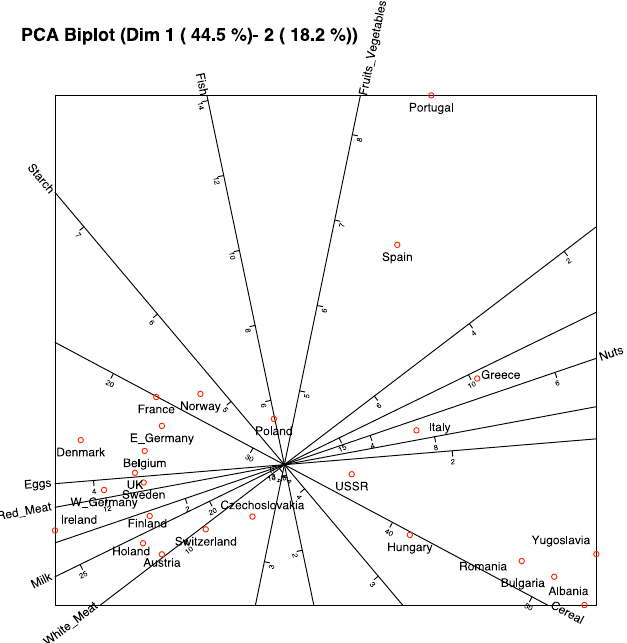
Figure 1. Prediction biplot with scale markers for the protein consumption data in European